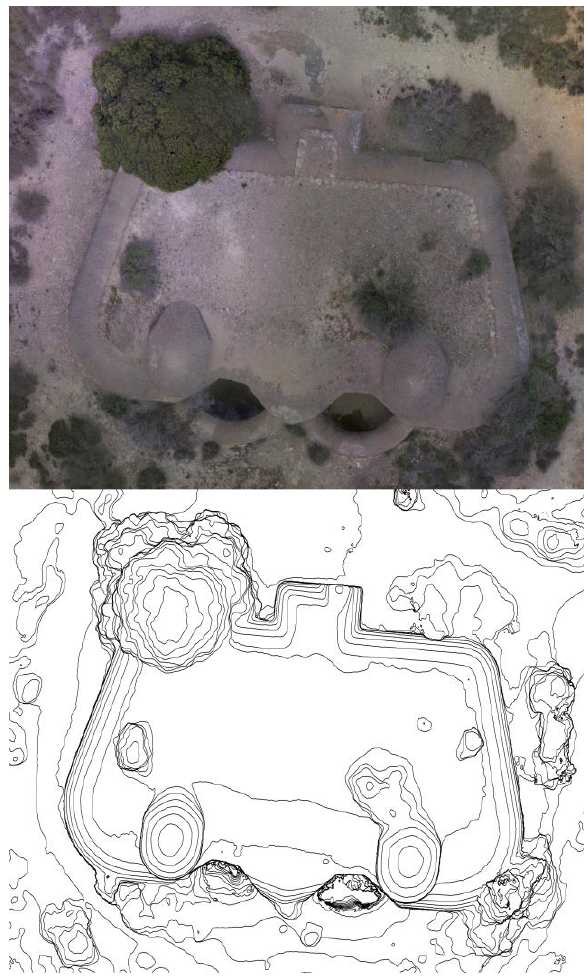
Figure 8. Different ways to filter the collected information: textured top view and level curves (photo & drawing: authors)